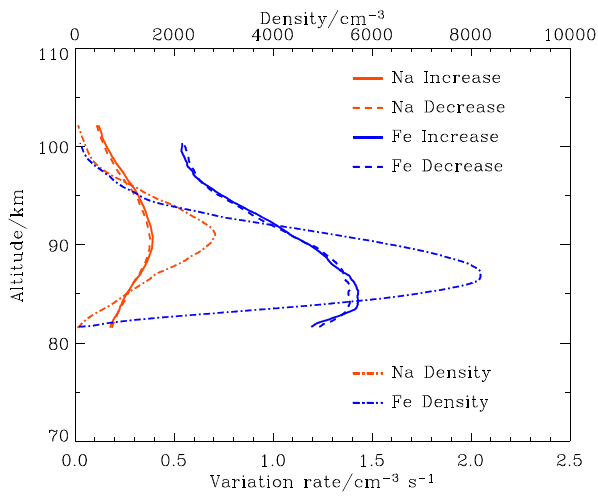
Fig. 13. Profiles of the mean increase and decrease rates for both Na and Fe. The profiles have been smoothed with running mean over 4.8 km in altitude. For comparison, the mean Na and Fe density profiles are presented.